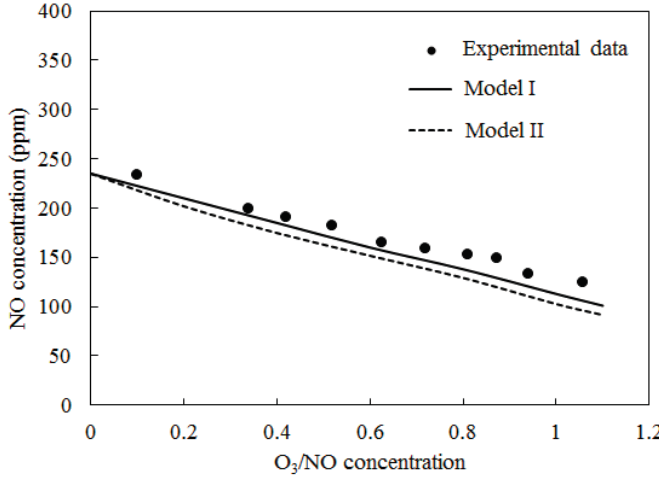
Figure 6. Variations of NO concentration with O 3 /NO concentrations at T = 300